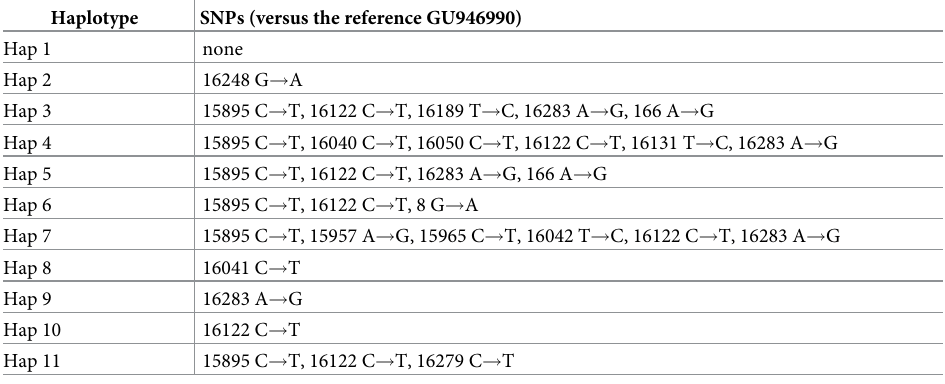
Table 1. MtDNA control region haplotypes determined by single nucleotide polymorphisms (SNPs) found in 14 U.S. Department of Interior and Parks Canada Agency bison herds.